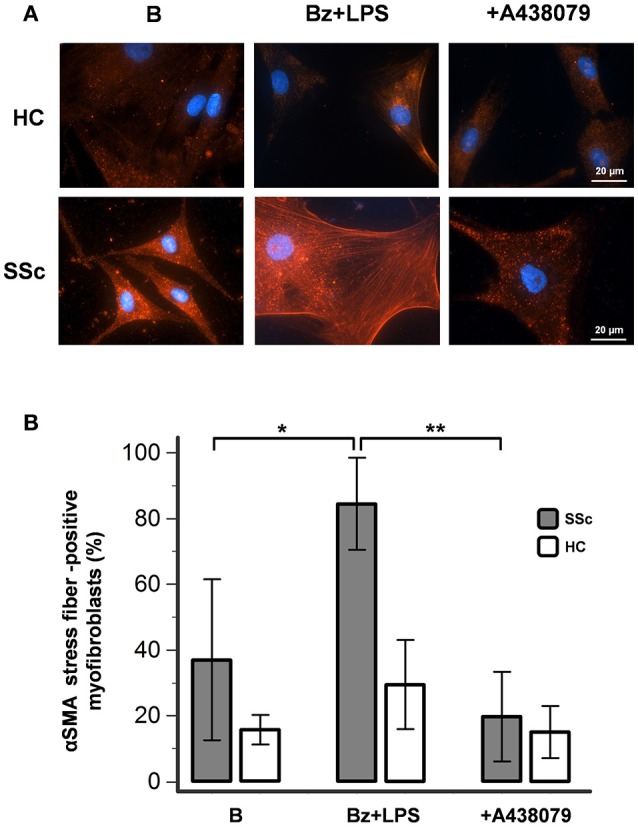
P2X7R activation promotes myofibroblast differentiation of SSc dermal fibroblasts. Effect of Bz+LPS stimulation on the differentiation of dermal fibroblasts to myofibroblasts, identified as large size and αSMA bundle (stress fiber)-positive cells by immunofluorescence. Fibroblasts from SSc patients and HC were starved for 24 h and then primed with LPS (1 μg/ml) or vehicle for further 24 h, followed by stimulation with Bz (0.1 mM) for 30 min, alone or after 2 h pre-incubation with the P2X7R antagonist A438079 (50 μM). (A) Representative figure of an experiment performed in SSc and HC fibroblasts, respectively: in red the immunofluorescence for α-SMA, while nuclei were stained in blue with DAPI. Images were acquired with a 60X/1.49 Apo objective. (B) Effect of Bz+LPS and Bz+LPS+AR438079 on myofibroblast differentiation, as determined by the percentage of αSMA stress fiber-positive cells. Histograms represent results (mean ± standard deviation) of experiments performed by using fibroblasts from SSc patients (n = 4) and HC (n = 3). RM-ANOVA, p = 0.012; post-hoc two-tailed Tukey–Kramer test, *p < 0.05, **p < 0.01. P2X7R, P2X7 receptor; SSc, Systemic sclerosis; B, baseline; Bz, 2′-3′-O-(4-benzoylbenzoyl)ATP; LPS, lipopolysaccharide; HC, healthy controls; DAPI, 4′,6-diamidino-2-phenylindole; ANOVA, analysis of variance.